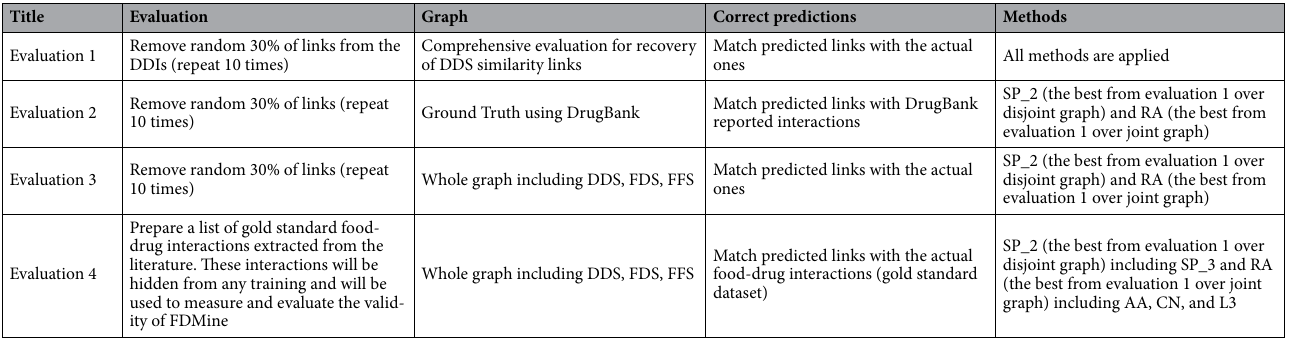
Table 2. List of evaluation